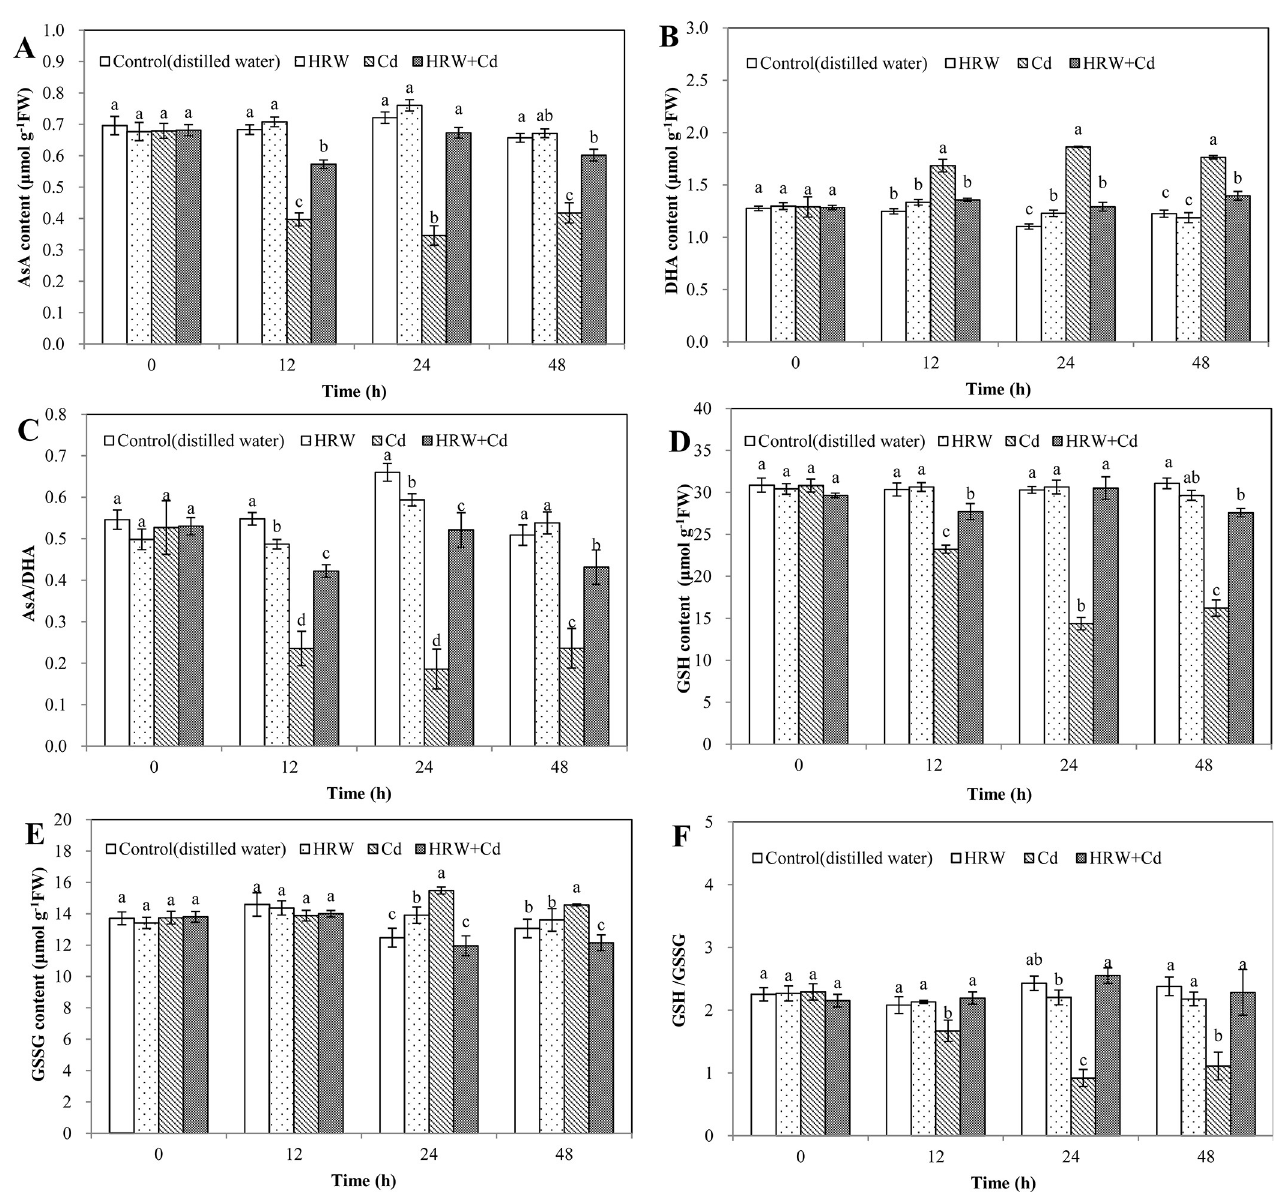
Fig 5. Effects of HRW on AsA content, DHA content, AsA/DHA, GSH content, GSSG content and GSH/GSSG during adventitious roots development in cucumber under Cd stress. The primary roots were removed from hypocotyls of 5-day-old cucumber seedlings. Explants were incubated for 2 d with distilled water (control), 50%HRW, 1 μ M Cd(NO 3 ) 2 , 50%HRW+1 μ M Cd(NO 3 ) 2 . AsA/DHA ( C ), GSH/GSSG ( F ) and the content of AsA ( A ), DHA ( B ), GSH ( D ) and GSSG ( E ) were measured at 0, 12, 24 and 48h and expressed as mean ± SE, respectively. Bars not sharing the same letters were significantly different ( P < 0.05).